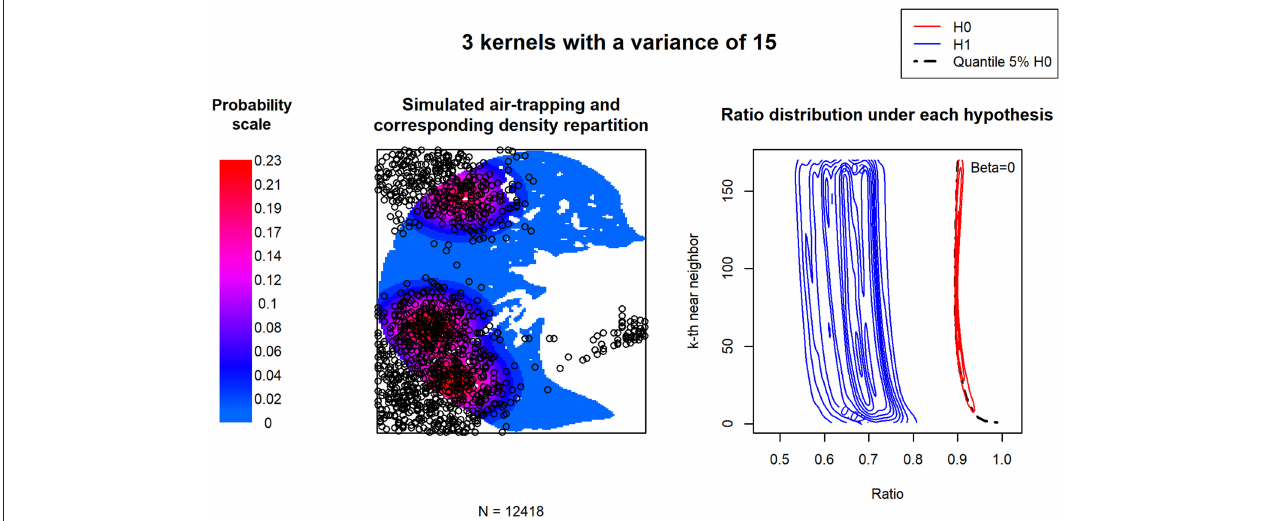
FIGURE 3 | Uniform neighborhood deviation curve (UNDC) ratios according to a clustered or heterogeneous point pattern. Three kernels define the density of the simulated air trapping. The low associated variance simulates a rather clustered repartition of air trapping. The density repartition of the R k curves is presented for 500 simulations.